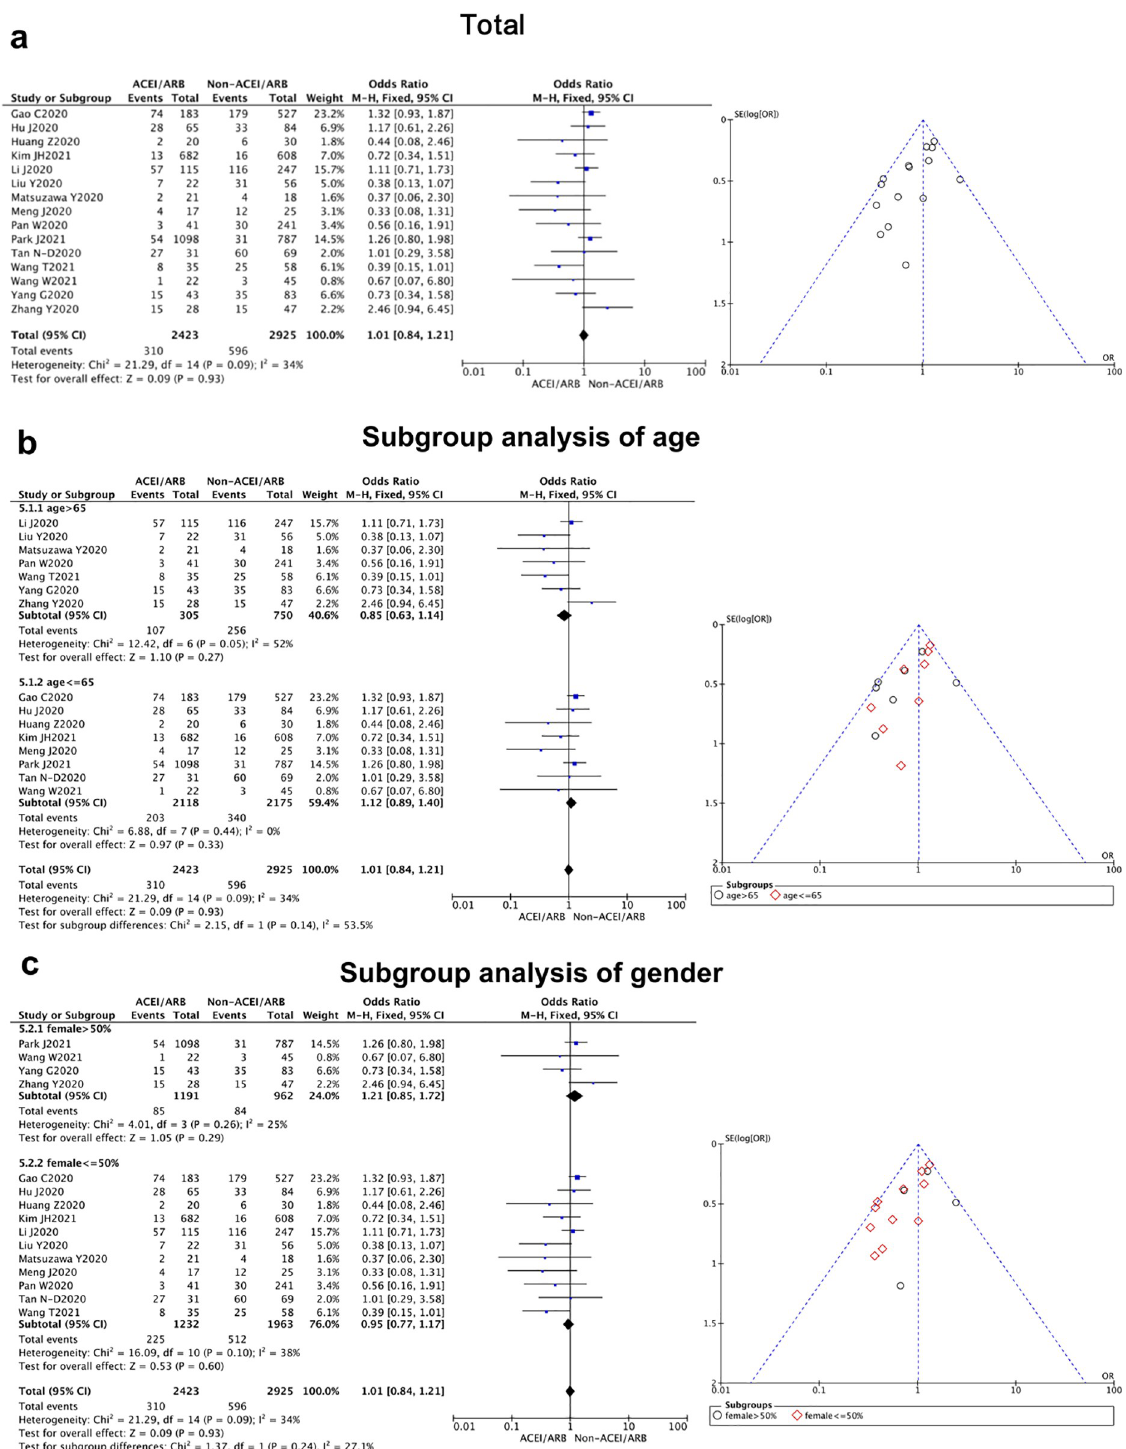
Fig 6. Severity of East-Asian Covid-19 patients treated with ACEI/ARB vs. untreated subjects (HT subgroup). The severity data of OR and 95% CI from 15 studies were pooled in this meta-analysis and the result of meta-analysis was described as a forest plot. (a) The whole group analysis; (b) The subgroup analysis of age; (c) The subgroup analysis of gender.